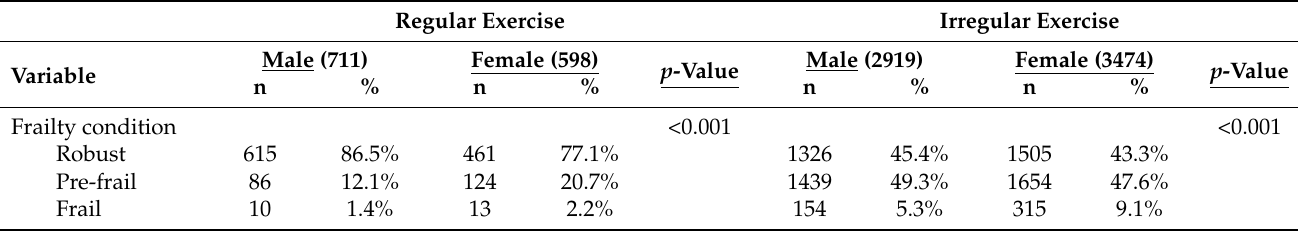
Table 2. Frailty and exercise habits of respondents of both sexes ( N =